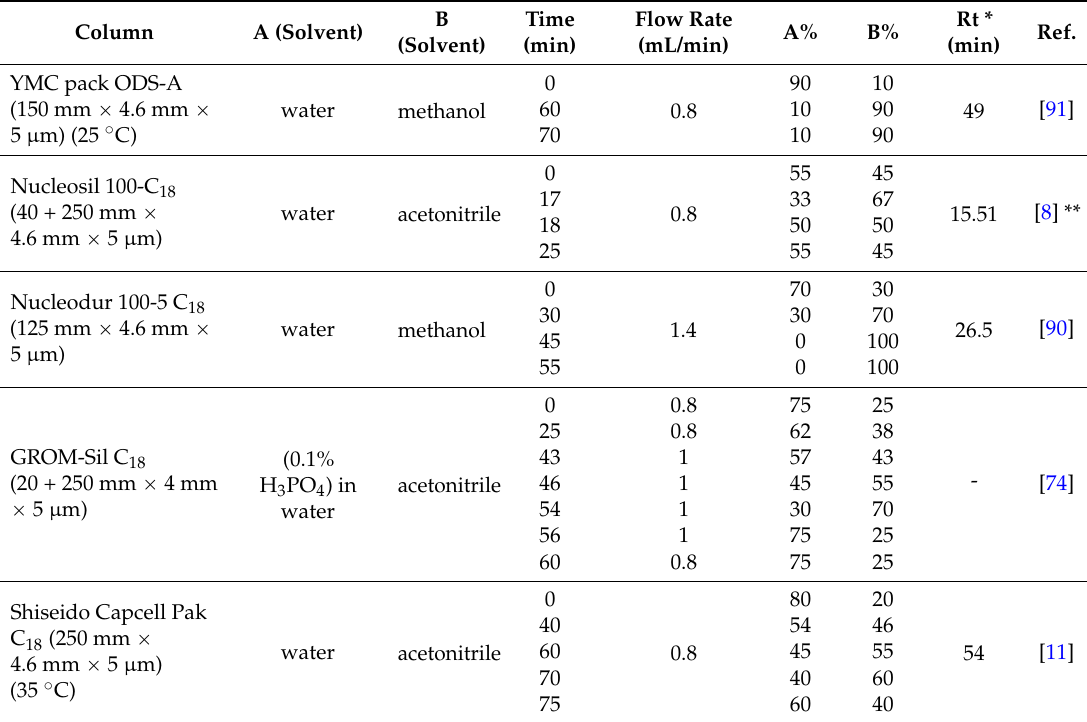
Table 3. Conditions to isolate and identify justicidin B by HPLC.